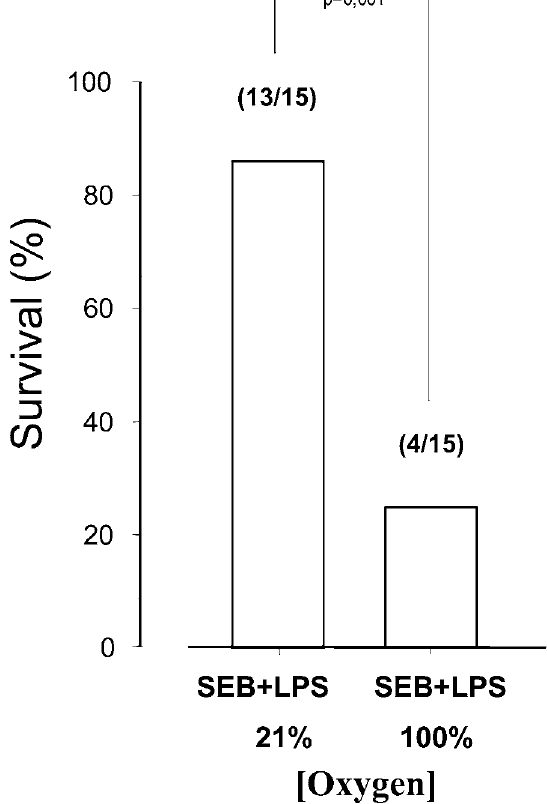
Figure 1. Increased Death Rate upon Oxygenation of Mice with Acute Lung Injury Mice were IT injected with SEB and LPS to model polymicrobial infection and were exposed to 21% or 100% oxygen for 48–60 h. Determination of time-dependent survival curves was prohibited by considerations of unrelieved severe respiratory distress in NIH- approved animal care protocol, which required termination of experiments immediately after differences between groups became apparent. Major differences between groups occurred within 48–60 hours after IT injection of toxins, when the majority of oxygenated animals with inflamed lungs had died, while the nonoxygenated, obviously sick control mice with inflamed lungs were still alive. DOI: